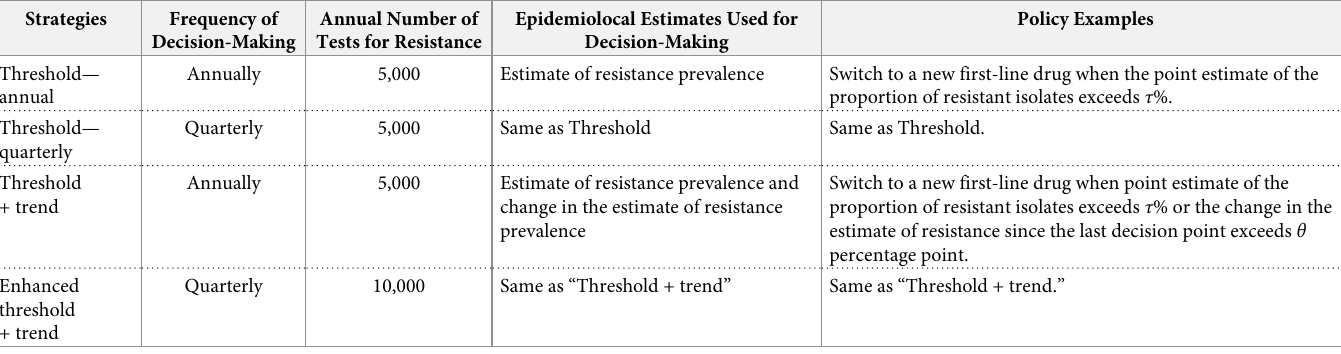
Table 1. Adaptive guidelines to inform first-line treatment recommendations for gonorrhea. Strategies Frequency of Annual Number of Decision-Making Tests for